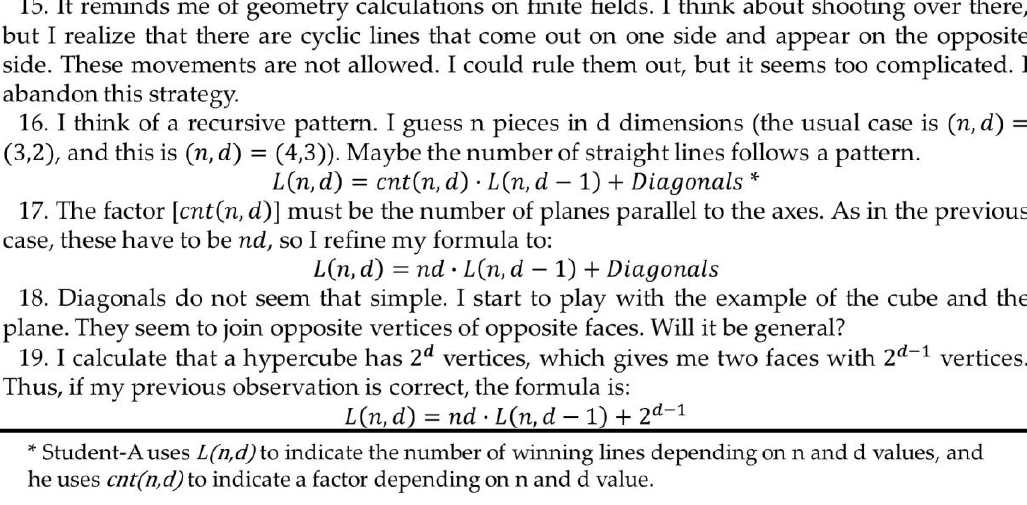
Figure 4. First excerpt of Student-A protocol: formula development phase.